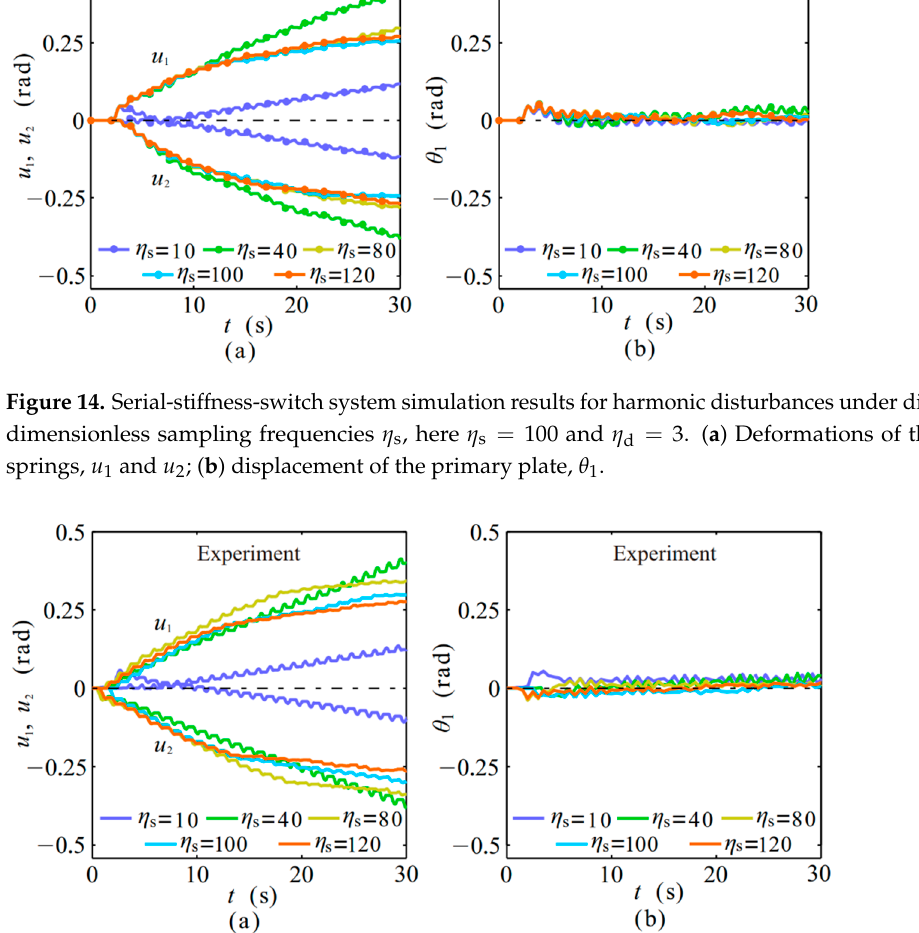
Figure 15. Serial-stiffness-switch system experiment results for harmonic disturbances under differ- ent dimensionless sampling frequencies, here 𝜂 (cid:2914) = 3 and 𝑀(cid:3553) (cid:2914) = 0.05Nm . ( a ) Deformations of the dimensionless sampling frequencies, here η d = 3, here η d = 3 and (cid:98) M d = 0.05 Nm. ( a ) Deformations two springs, 𝑢 (cid:2869) and 𝑢 (cid:2870) ; ( b ) displacement of the primary plate, 𝜃 (cid:2869) . of the two springs, u 1 and u 2 ; ( b ) displacement of the primary plate, θ 1